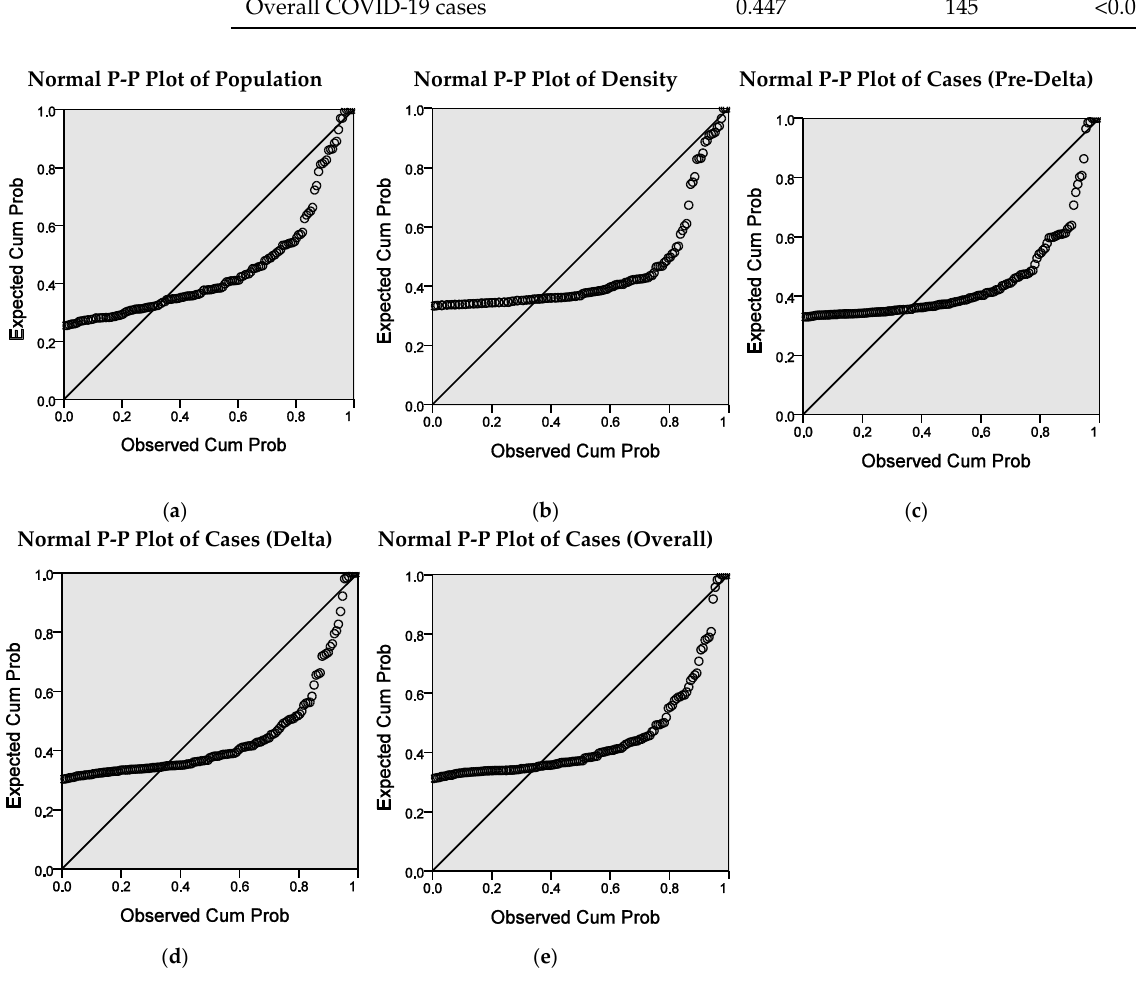
Figure A2. Absolute population by district, Malaysia (projected year 2020).